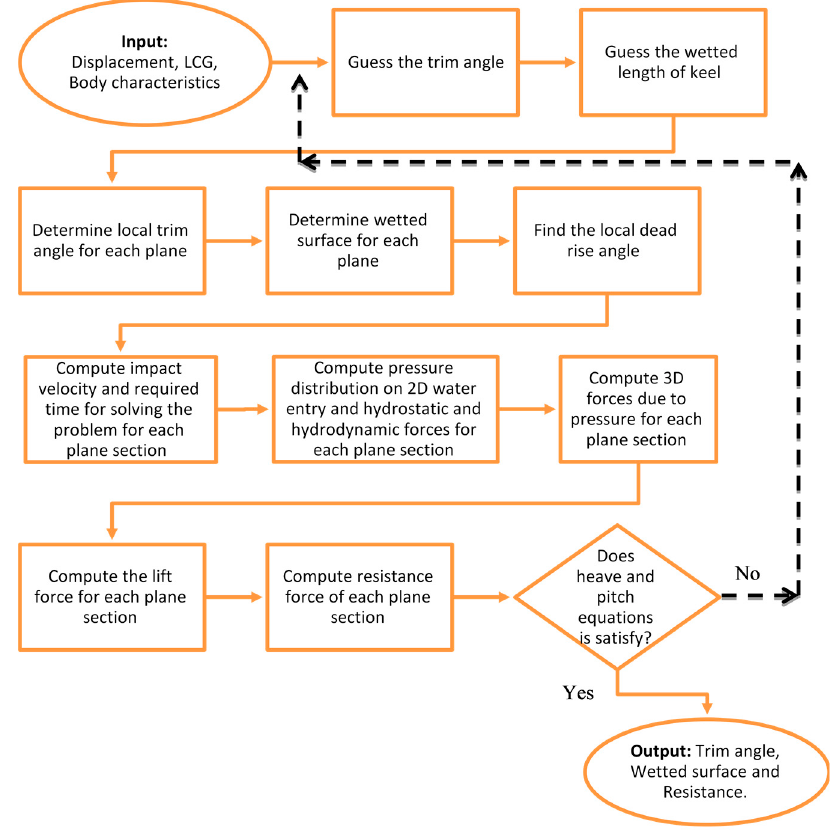
Figure 6. The computational workflow for determining the pressure distribution of the single-stepped planing hull.